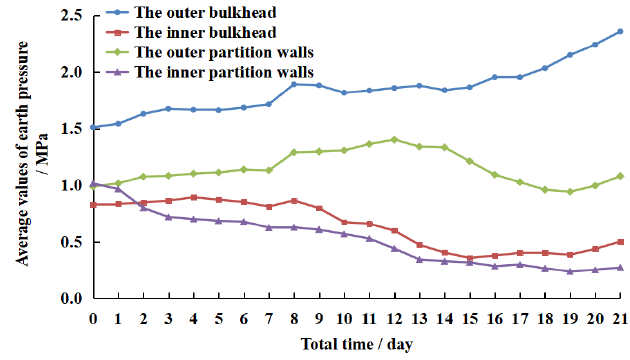
Figure 17. Variation curves of average measured earth pressure.